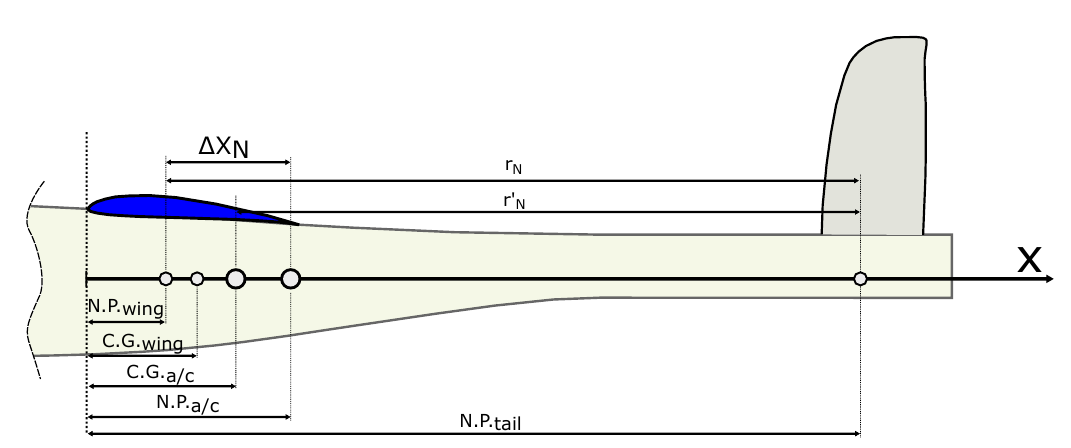
Figure 3. Aircraft Reference Points